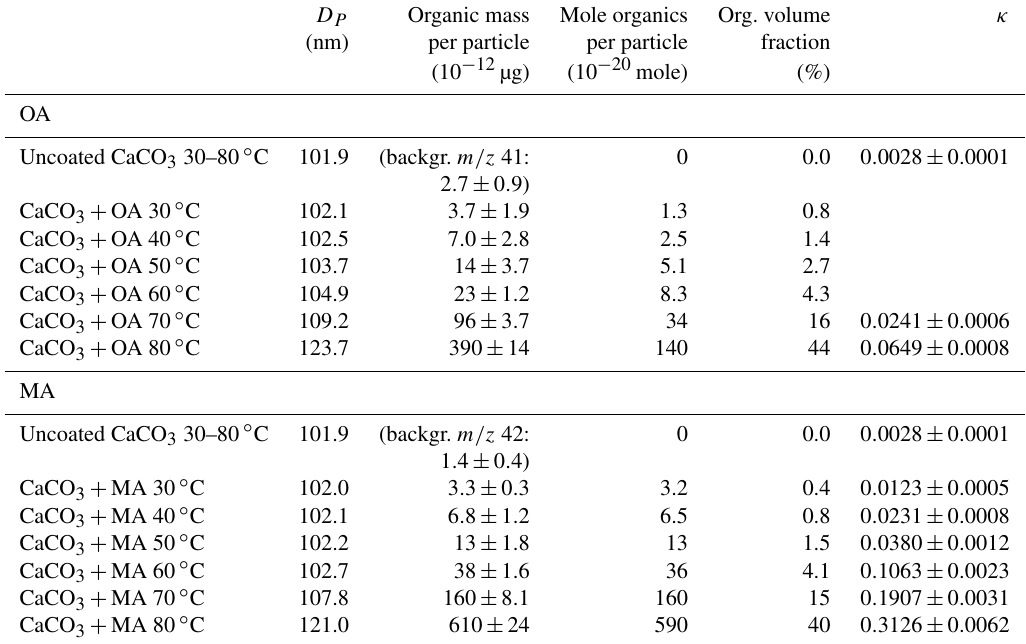
Table 1. Mode diameters, chemical compositions, and κ values of CaCO 3 aerosol particles (size selected by DMA at 101.8nm) before (uncoated) and after coating with oleic acid (OA) or malonic acid (MA) at 30–80 ◦ C. D P Organic mass Mole organics Org. volume κ (nm) per particle per particle fraction (10 − 12 µg) (10 − 20 mole) (%)